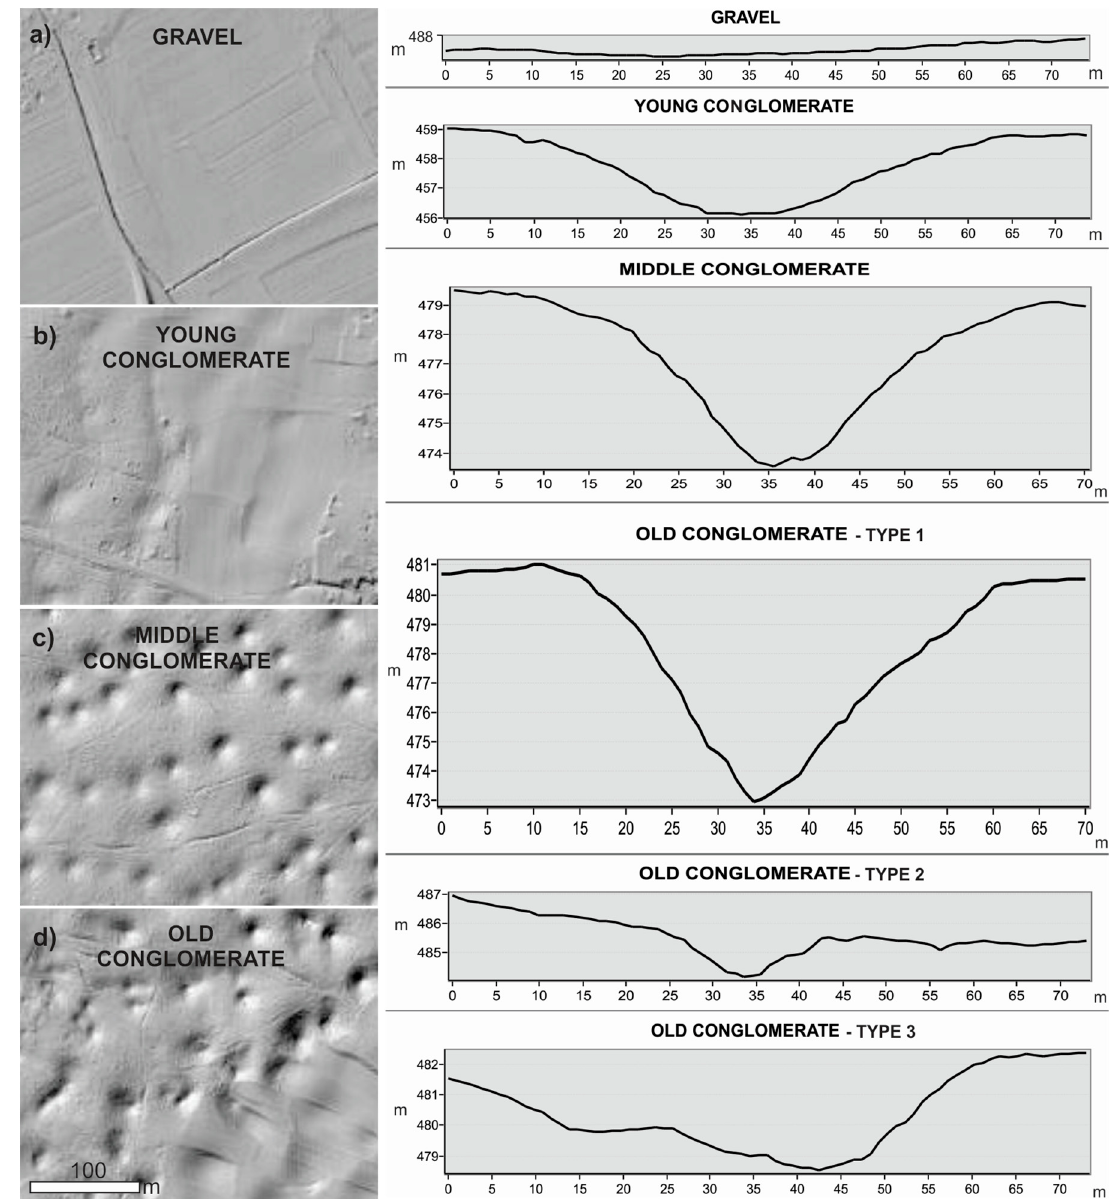
Figure 16. The typical surface morphology of gravel and karstified conglomerates by age with the profiles across characteristic dolines. ( a ) Gravel: flat surface with no surface features; ( b ) Young conglomerate: flat surface with scarce shallow surface features (dolines and linear depressions); ( c ) Middle conglomerate: rather flat surface with uniform dolines of high density; ( d ) Old conglomerate: irregular surface with depressions of high morphologic heterogeneity (profiles across the three types of dolines).